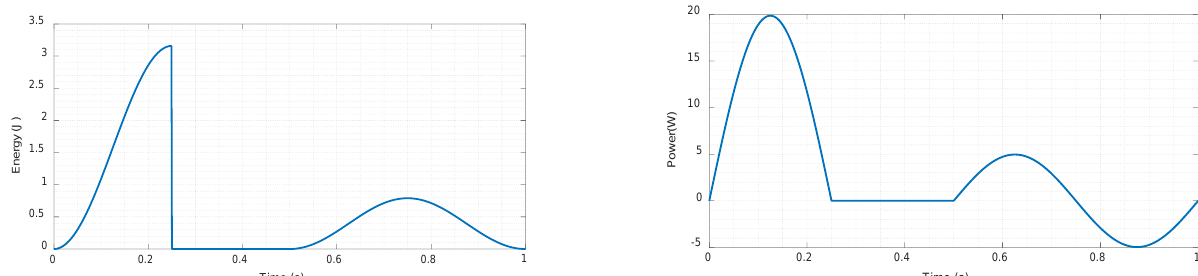
Figure 9. Kinetic energy in the Y-axis of the system with w = 60 rpm, m = 1 kg and r = 0.2 m ( left ), and power consumption associated with kinetic energy variation, m = 1 kg, w = 60 rpm, r = 0.2 m ( right ).